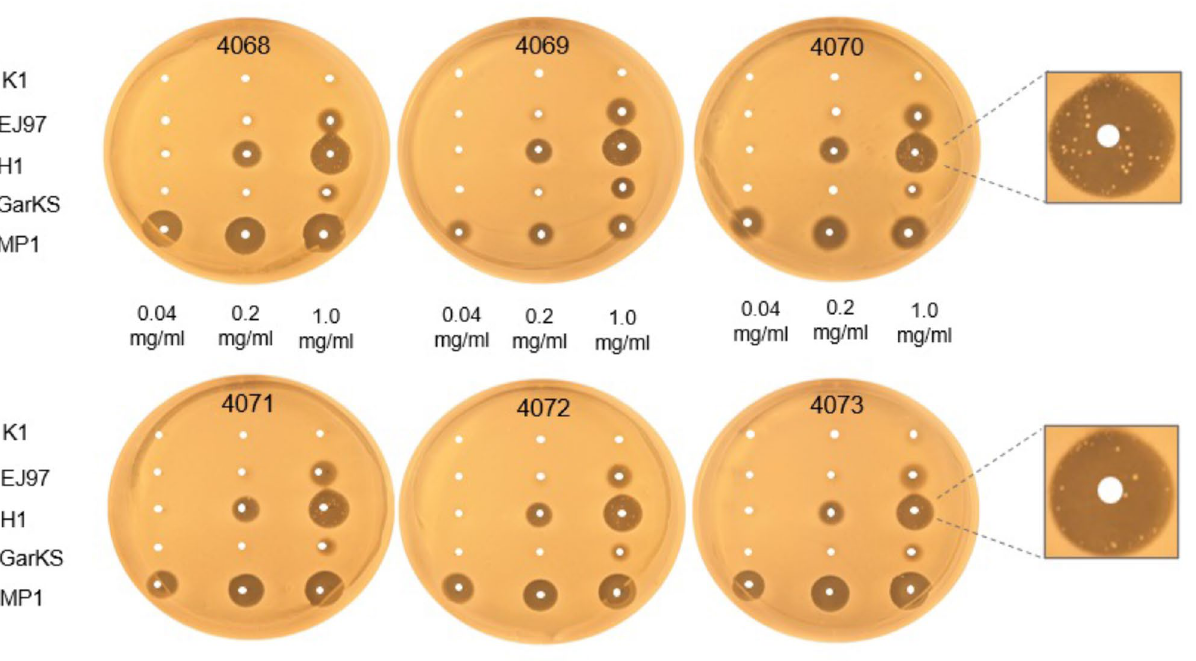
Figure 2. Comparison of the antimicrobial activities of the bacteriocins against S. haemolyticus . The antimicrobial activity of the indicated bacteriocins was assessed by “spot-on-lawn” assay against six S. haemolyticus strains, 4068–4073 . The bacteriocins were applied at three different concentrations (0.04, 0.2, and 1.0 mg/ml), and 5 µl of each was spotted on the lawns of the S. haemolyticus strains. All strains developed resistance to H1 after 24 h incubation, as illustrated for strains 4070 and